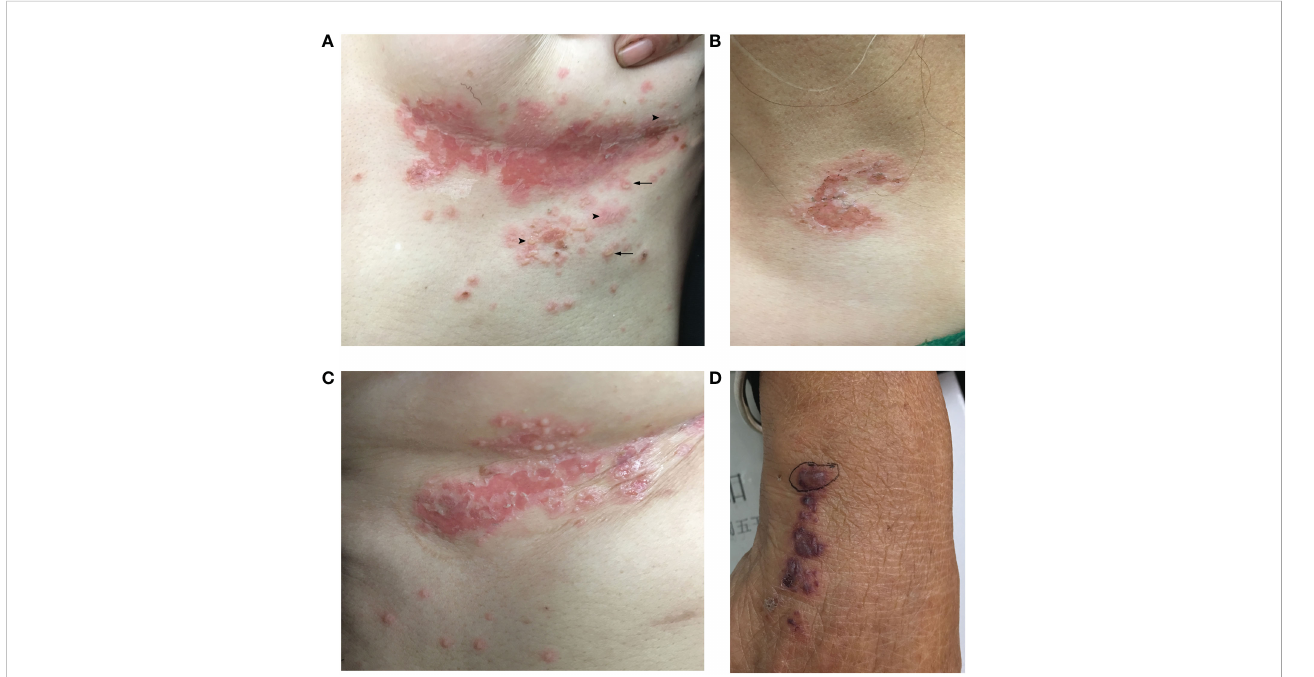
FIGURE 1 Clinical skin manifestation of the patient. (A) Multiple fl accid vesicles, pustules, and erosions on the left inframammary fold. Arrowhead: multiple fl accid vesicles and bullae. Arrow: a few pustules with the appearance of “ half – half ” blisters. (B) Erosion with erythema over the left supraclavicular area. (C) Multiple vesicles and erosions on the right inframammary fold. (D) Purpura and a hemorrhagic bulla on the right